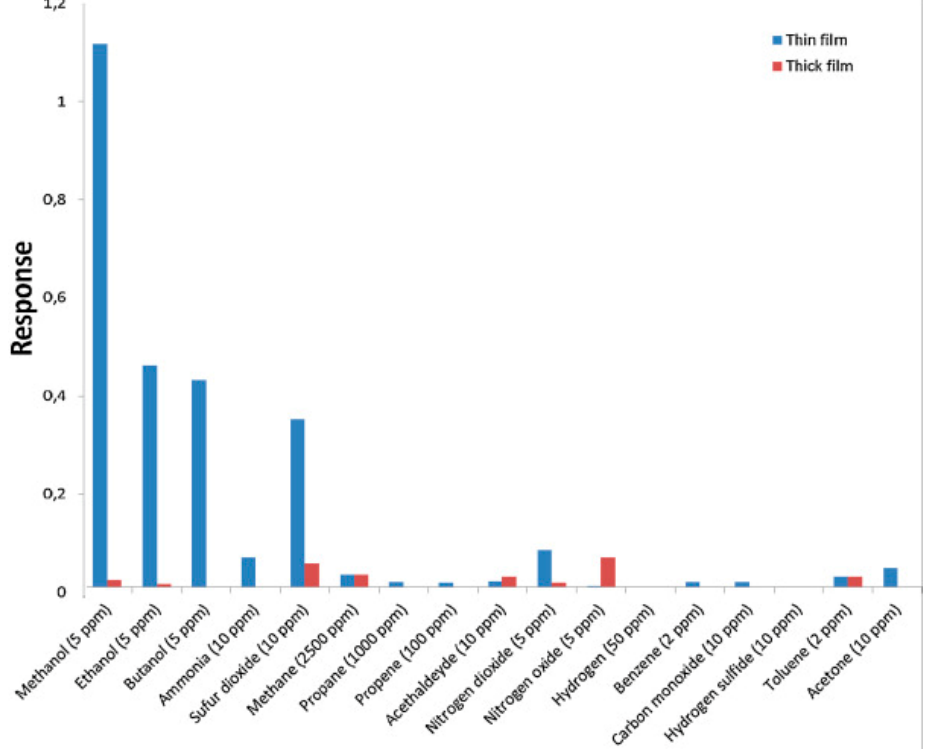
Figure 7. Comparison of sensing response towards various gas samples for the cases of thin and thick